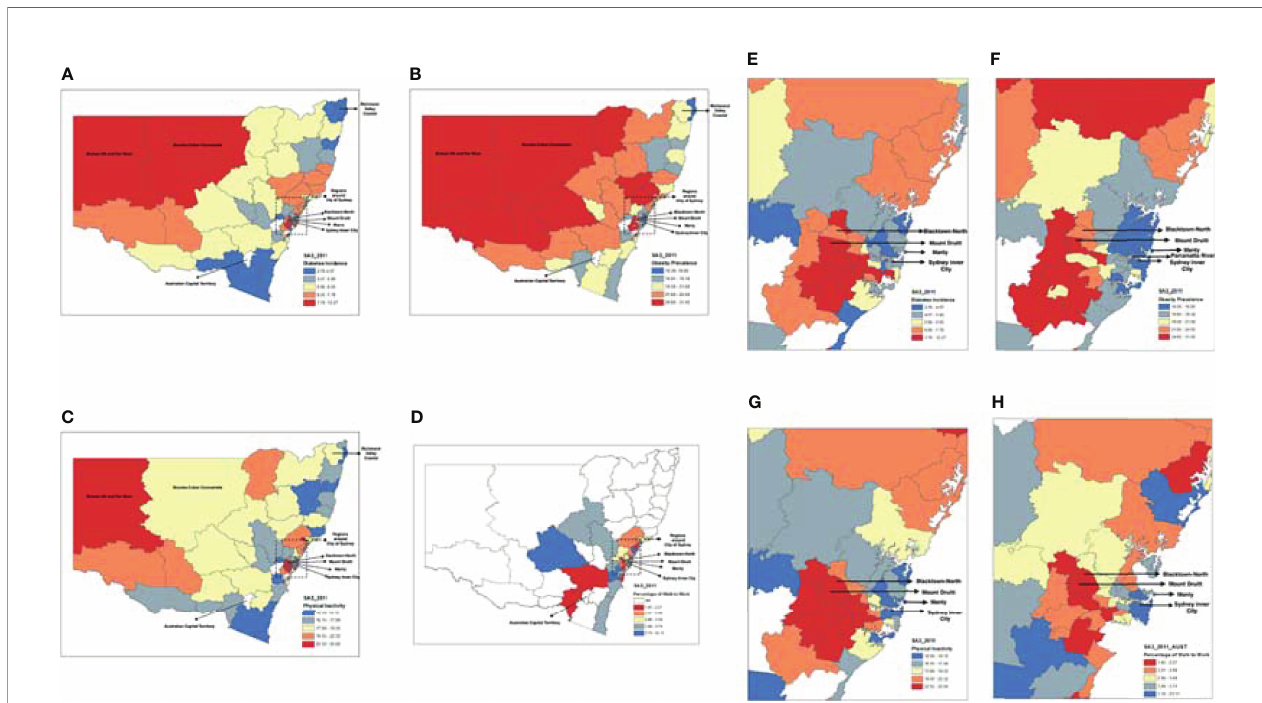
FIGURE 3 | Geographic Variations in the Incidence of Diabetes, Obesity Prevalence, Percentage of the Population with Insuf fi cient Physical Activities and Percentage of the Population Walking to Work. (A) shows the variations in T2DM incidence at SA3 level with a Univariate Moran ’ s I of 0.52 (p=0.001) while (E) shows T2DM incidence in the magni fi ed Sydney region; (B) shows the variance of obesity prevalence at SA3 level with a Univariate Moran ’ s I of 0.67 (p=0.001) while (F) shows obesity prevalence in the magni fi ed Sydney region, and by comparing between (A, B) , it can be identi fi ed a very similar pattern between them with a Bivariate Moran ’ s I of 0.37 (p=0.001) and an intraclass correlation coef fi cient of 0.6 (p<0.001); (C) shows the variance of the percentage of the population with insuf fi cient physical activities at SA3 level with a Univariate Moran ’ s I of 0.59 (p=0.001) while (G) shows the percentage of the population with insuf fi cient physical activities in the magni fi ed Sydney region, by comparing between (A, C) , it can be identi fi ed a very similar pattern between them with a Bivariate Moran ’ s I of 0.54 (p=0.001) and an intraclass correlation coef fi cient of 0.8 (p < 0.001); (D) shows the variance of the percentage of the population walking to work at SA3 level with a Univariate Moran ’ s I of 0.44 (p=0.001) while (H) shows the percentage of the population walking to work in the magni fi ed Sydney region, and by comparing between (E, H) , it can be identi fi ed a similar pattern between them with a Bivariate Moran ’ s I of -0.23 (p=0.001) and an intraclass correlation coef fi cient between T2DM incidence and percentage of the population walking to work of -0.47 (p < 0.001); by comparing between, it can be identi fi ed a very similar pattern between them with and an intraclass correlation coef fi cient of 0.61 (p <